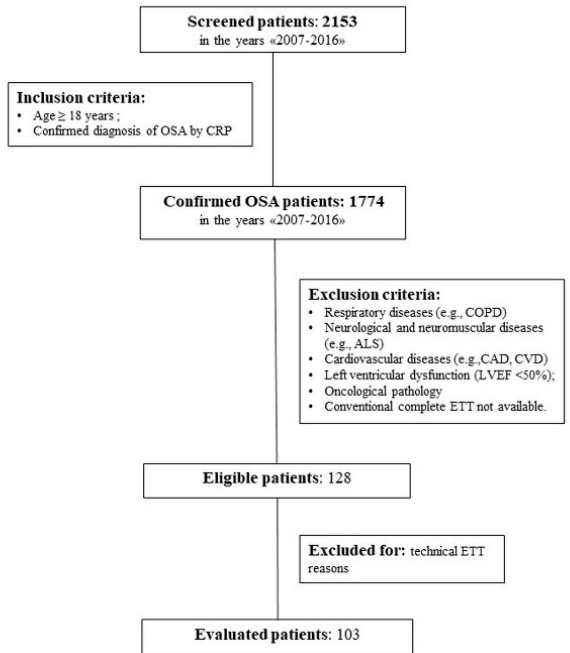
Figure 1. Study flowchart. Legend: nCRP = nocturnal eight-channel cardiorespiratory polygraphy; OSA = obstructive sleep apnea; COPD = chronic obstructive pulmonary disease; ALS = amyotrophic lateral sclerosis; CAD = coronary artery disease; CVD = coronary vascular disease; LVEF = left ventricular ejection fraction; ETT = comprehensive transthoracic two-dimensional and Doppler echocardiography examination.